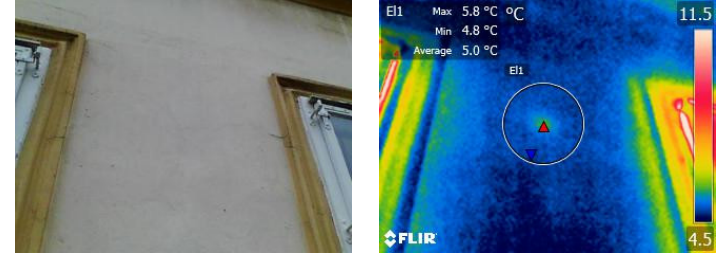
Figure 18. Discovered weak point heat bridge.